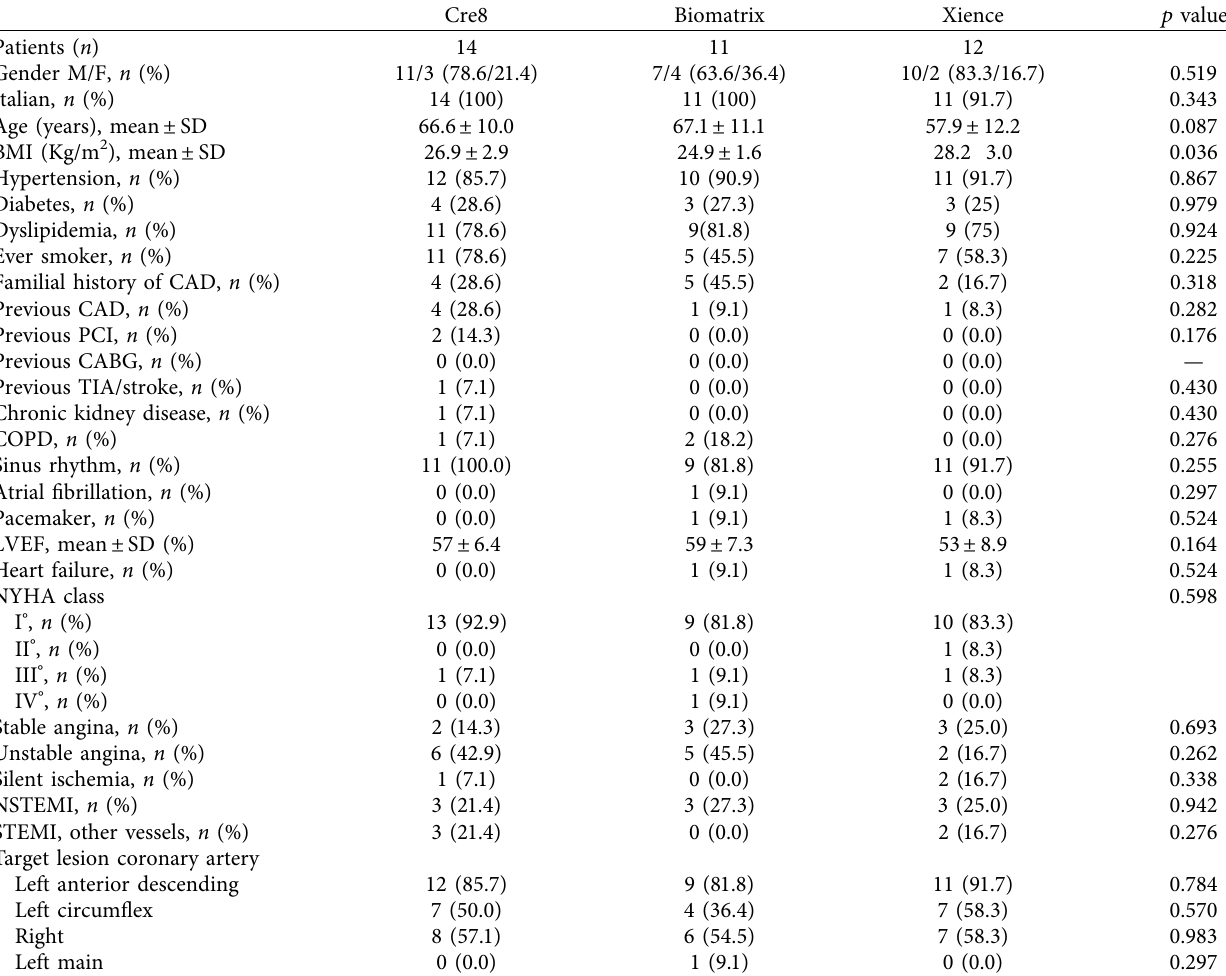
Table 1: Baseline clinical, angiographic, and PCI characteristics.